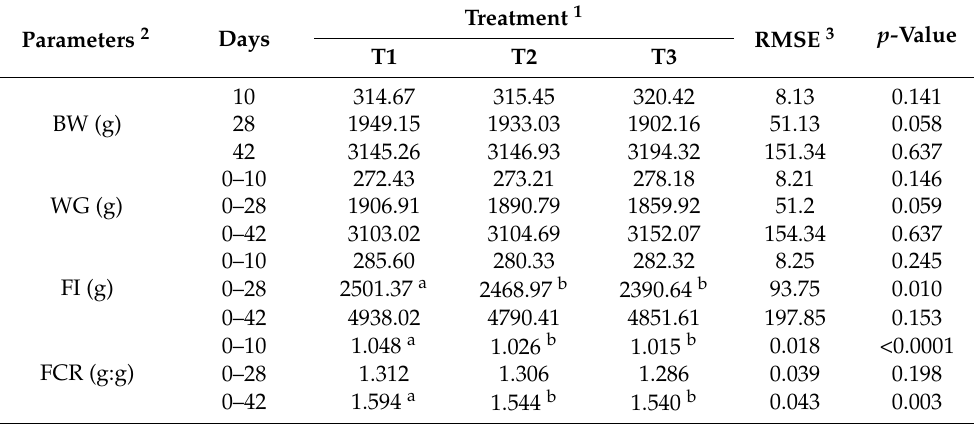
Table 3. Effects of guanidinoacetic acid (GAA) supplementation for male broilers on growth perfor- mance up to 42 days of